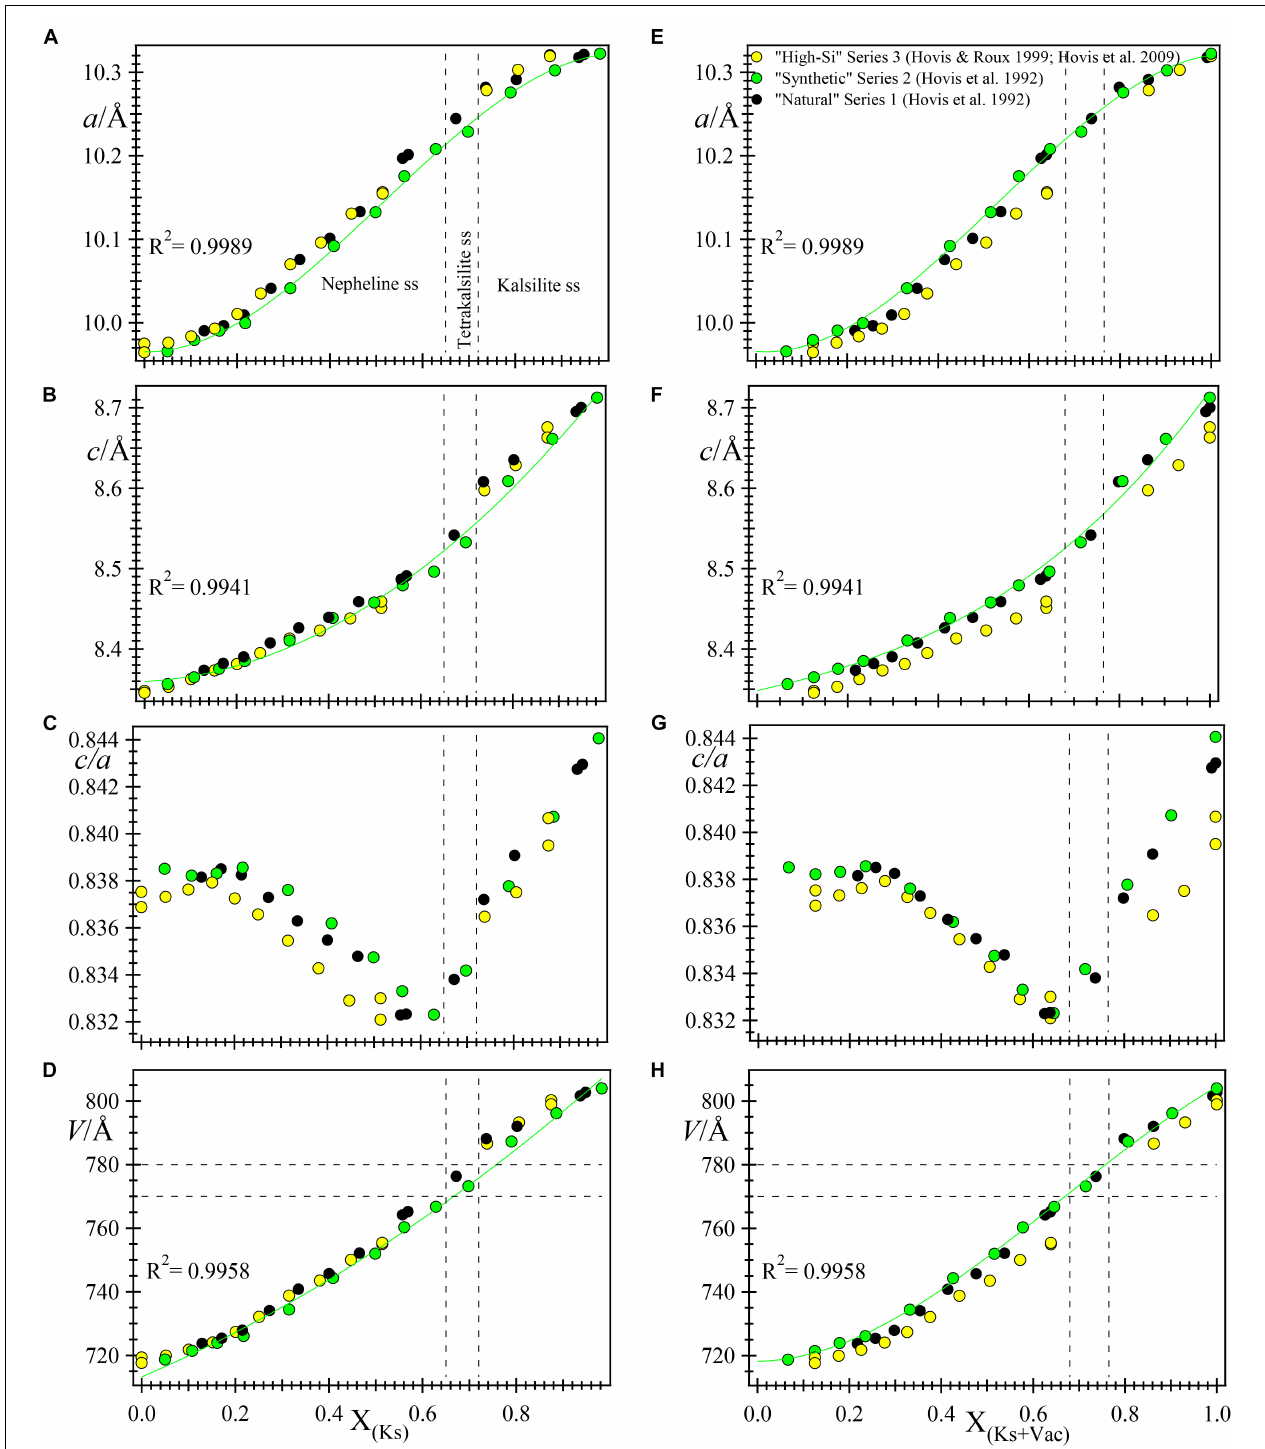
FIGURE 2 | A re-plot of the unit-cell parameters against X Ks ( A–D, left column) and X ( Kls + Vac ) ( E–H, right column) for samples from three ion-exchange nepheline-kalsilite series (see legend in E ). Polynomials are fitted to the “synthetic” series 2 and their R 2 values are given as inserts ( a is fitted to a 3rd order polynomial, whereas c and V are fitted to 2nd order polynomials). The dashed vertical lines are the boundaries for the two tetrakalsilite samples: they are drawn at 0.65 and 0.72 X Kls and 0.68 and 0.765 X ( Kls + Vac ) . To the left of tetrakalsilite are nepheline solid solutions and to the right are data for the kalsilite series. Only the c / a variable, which was not plotted in the original papers, appear to show a kink at ≈ 0.24 X ( Kls + Vac ) where it was suggested that K atoms begin to enter the B site in nepheline solid solutions (C,G) .